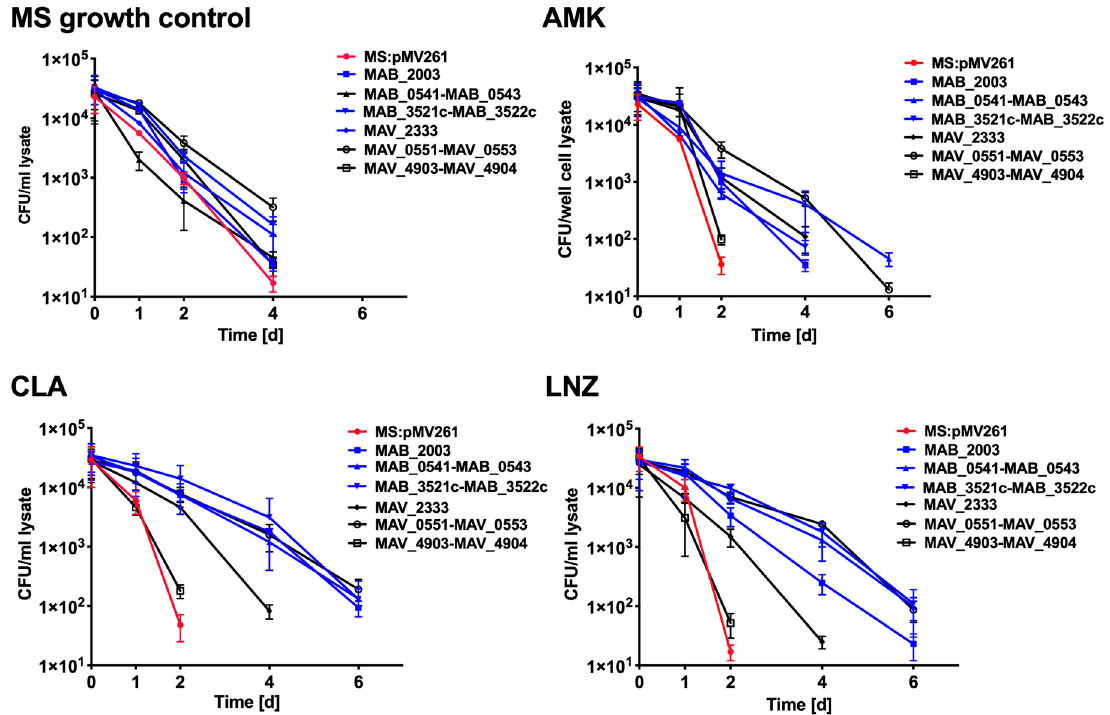
Figure 10. The killing dynamics of M. smegmatis expressing MAB and MAH homologous genes of common metabolic pathways in THP-1 macrophages.